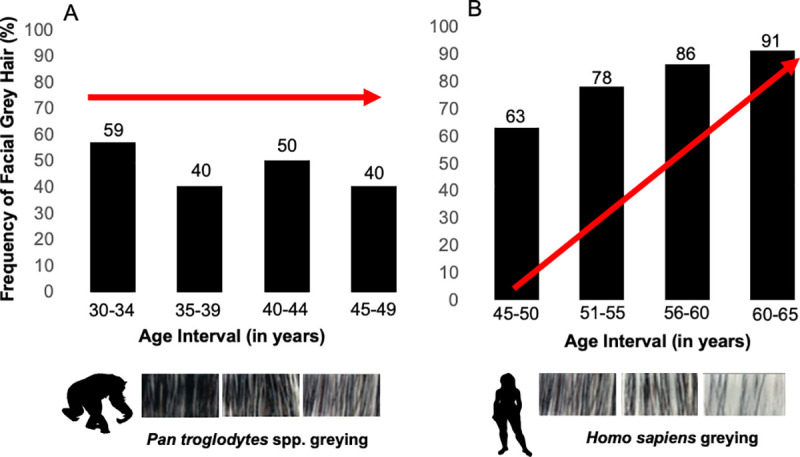
Frequency of facial hair greying after mid-life in (A) chimpanzees and (B) humans (generated from data of [3]). Greying scales below the charts (adapted from [3]) show the extent of greying observed in each species. Red arrows illustrate the direction of change in greying is (A) horizontal change, and (B) positive linear change.